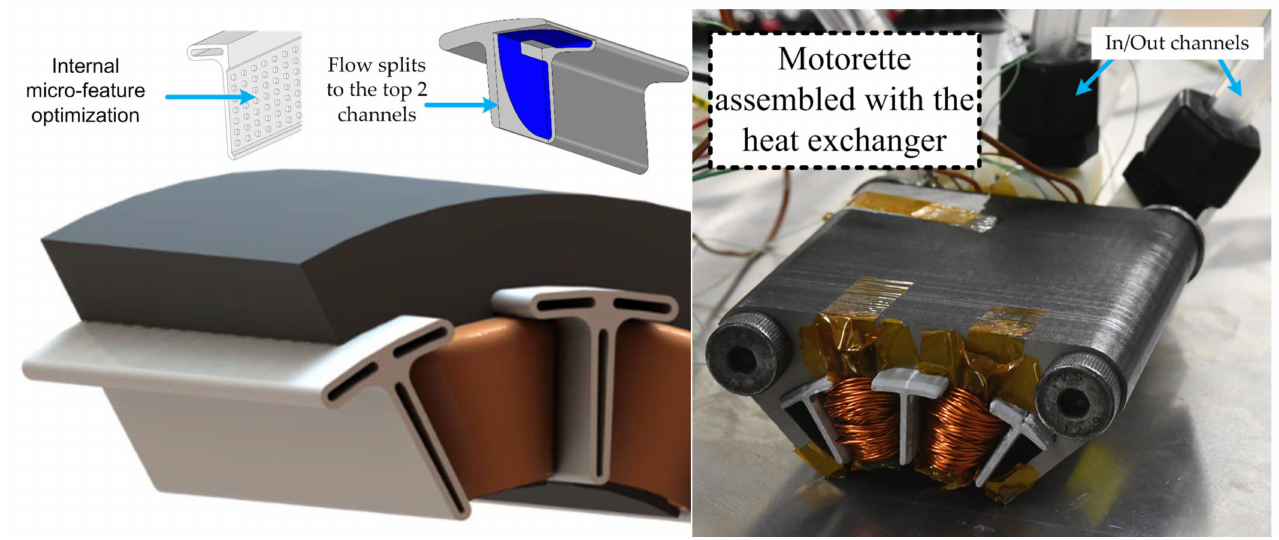
Figure 22. Ceramic 3D-printed direct-winding heat exchangers for improved thermal perfor- mance [90,91].